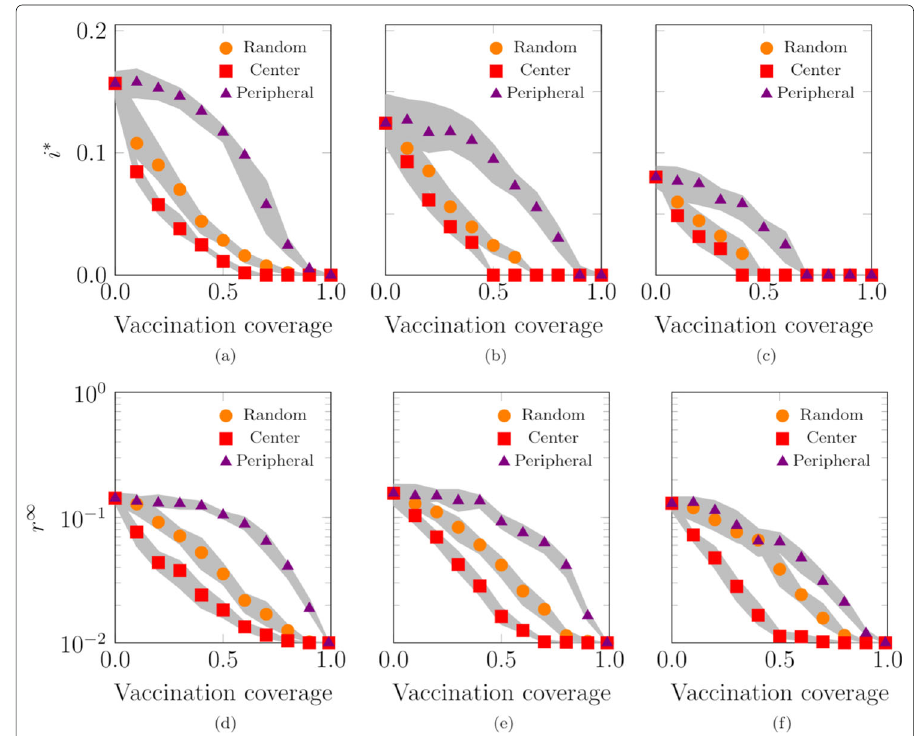
Fig. 11 Effect of different vaccination strategies on the endemic prevalence (SIS model), a - b - c , and epidemic size (SIR model), d - e - f . The vaccination coverage represents the fraction of immune agents prior to the disease onset. In “Random”, we select the fraction of agents to vaccinate at random; in “Center”, we vaccinate first the agents that are assigned to central base locations, while in “Peripheral”, we prioritize vaccination for agents that belongs to the peripheral agents. We set: a - d p = 0.1 and α = 0.0, b - e p = 0.4 and α = 0.2, and c - f p = 0.8 and α = 0.4. Curves represent the median of 100 independent simulations; 95% confidence bands are displayed in gray. Agents are initially inside their base location and the infection starts after 100 steps to allow the agents to reach a steady-state configuration. The fraction of randomly chosen initial infected is 0.01. Other parameter values are L = 100, N = 10,000, D = 10 9 , (cid:6) min = 100, (cid:6) max = 10,000, σ = 1, σ = 1,000, v = 500, c = 4 · 10 − 4 , ω = 2.4, γ = 2.1, λ = 0.15, and μ = min max